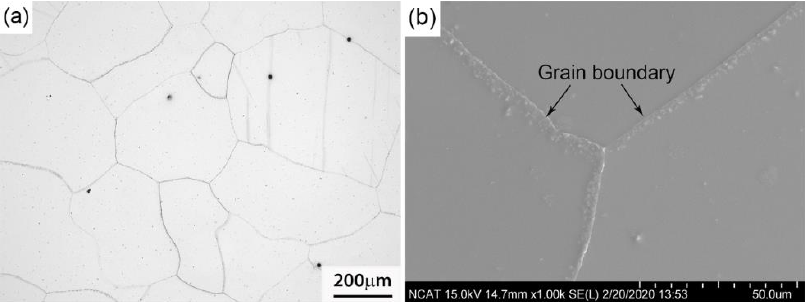
Figure 2. Microstructures of the starting homogenized plate by OM in ( a ) and SEM in ( b ).